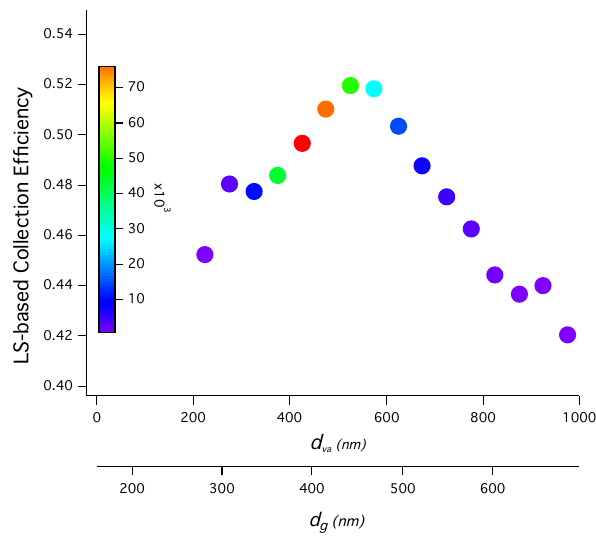
Fig. 3. LS-based collection efficiency versus particle size. Point col- ors indicate number of particles measured in the corresponding size, with color scale shown by the vertical bar.